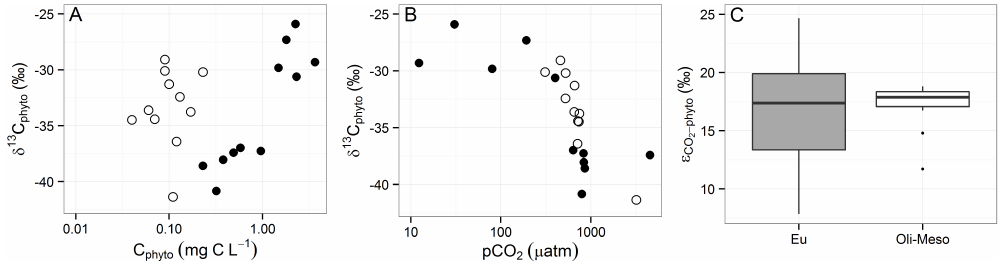
Figure 5. The relation of δ 13 C phyto in eutrophic lakes (filled circles, n = 11) and oligo-mesotrophic lakes (open circles, n = 11) to (a) C phyto and (b) p CO 2 . Panel (c) presents a box whisker plot of calculated ε CO